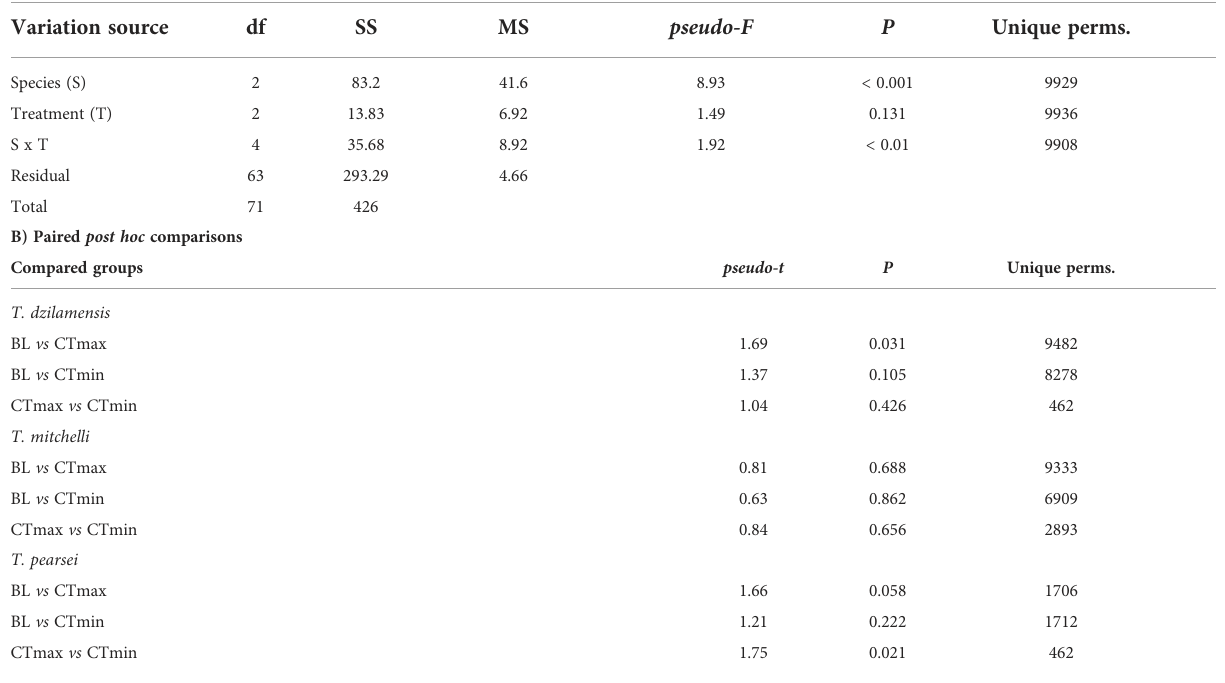
TABLE 3 Results of the permutational MANOVA on the biochemical indicators of individuals of T. mitchelli , T. pearsei and T. dzilamensis subjected to procedures to obtain the critical thermal maximum and minimum (CTmax and CTmin) which were compared to baseline individuals